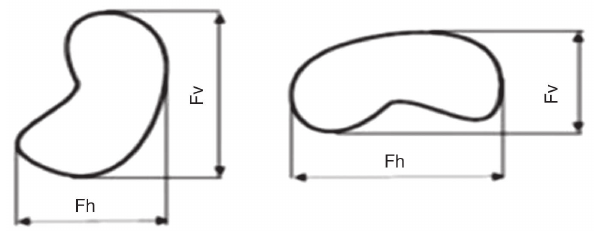
Figure 4: Illustration of Horizontal and Vertical Feret Diameters of a Particle, Fh and Fv, respectively (Wikipedia).